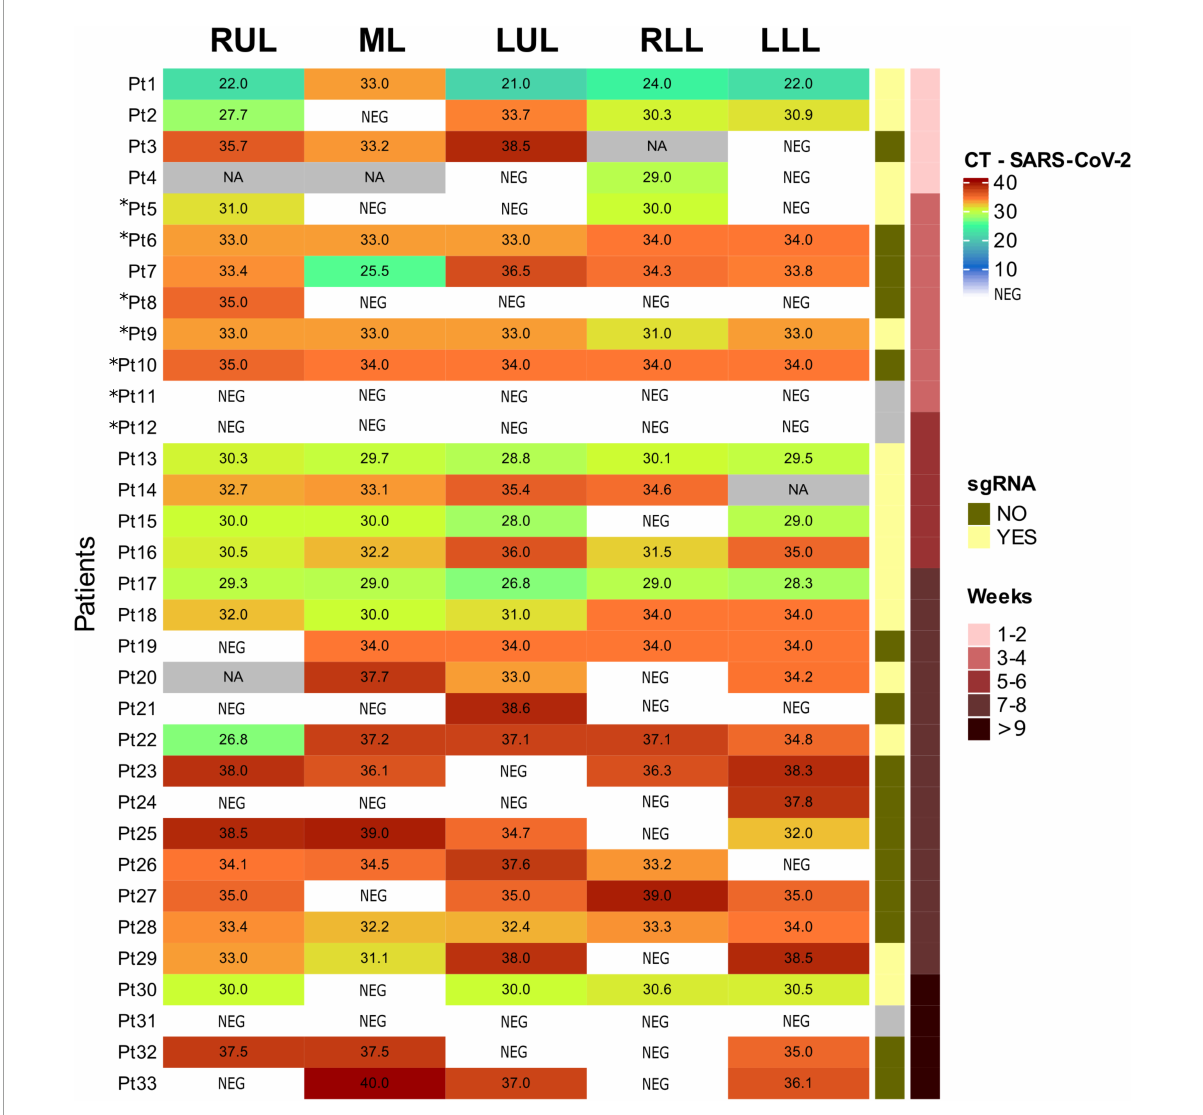
FIGURE3 Sars-Corv-2 gRNA and sgRNA in lung samples. RUL, right upper lobe; ML, medium lobe; LUL, left upper lobe; RLL, right lower lobe; LLL, left lower lobe; CT, cycle threshold; NEG, negative; NA, non-available; sgRNA, subgenomic RNA. Patients not included in (17) are 5, 6, 8, 9, 10, 11, and 12 (with